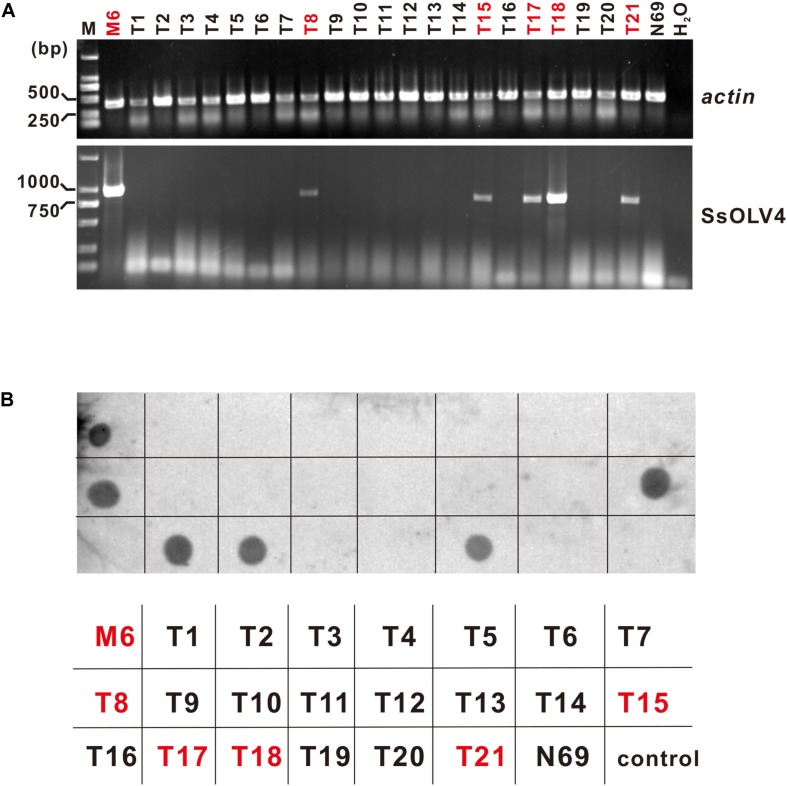
Detection of synthesized SsOLV4 RNA in the strains transfected using mycelia as the receptor. As described in the section “Materials and Methods,” the linearized vector pMD18-P1 was used to synthesize SsOLV4 RNA. The synthesized viral RNA was mixed with PEG buffer and added onto tips of fresh mycelia of strain N69. The infection experiments were performed on 21 colonies of strain N69. Each colony treated (named as T1 to T21) was subcultured three times (for about 10 days). The total RNA of all strains obtained was isolated to detect SsOLV4 using RT-PCR (A) and dot blot (B). The RT-PCR primers and dot hybridization probe were the same as used in Figure 5. Total RNAs of strains M6 and N69 were used as positive and negative controls, and water (H2O) was used as a blank control. In (B), the parallelism strain name was listed under the dot hybridization result. Strains infected with SsOLV4 were indicated in red.